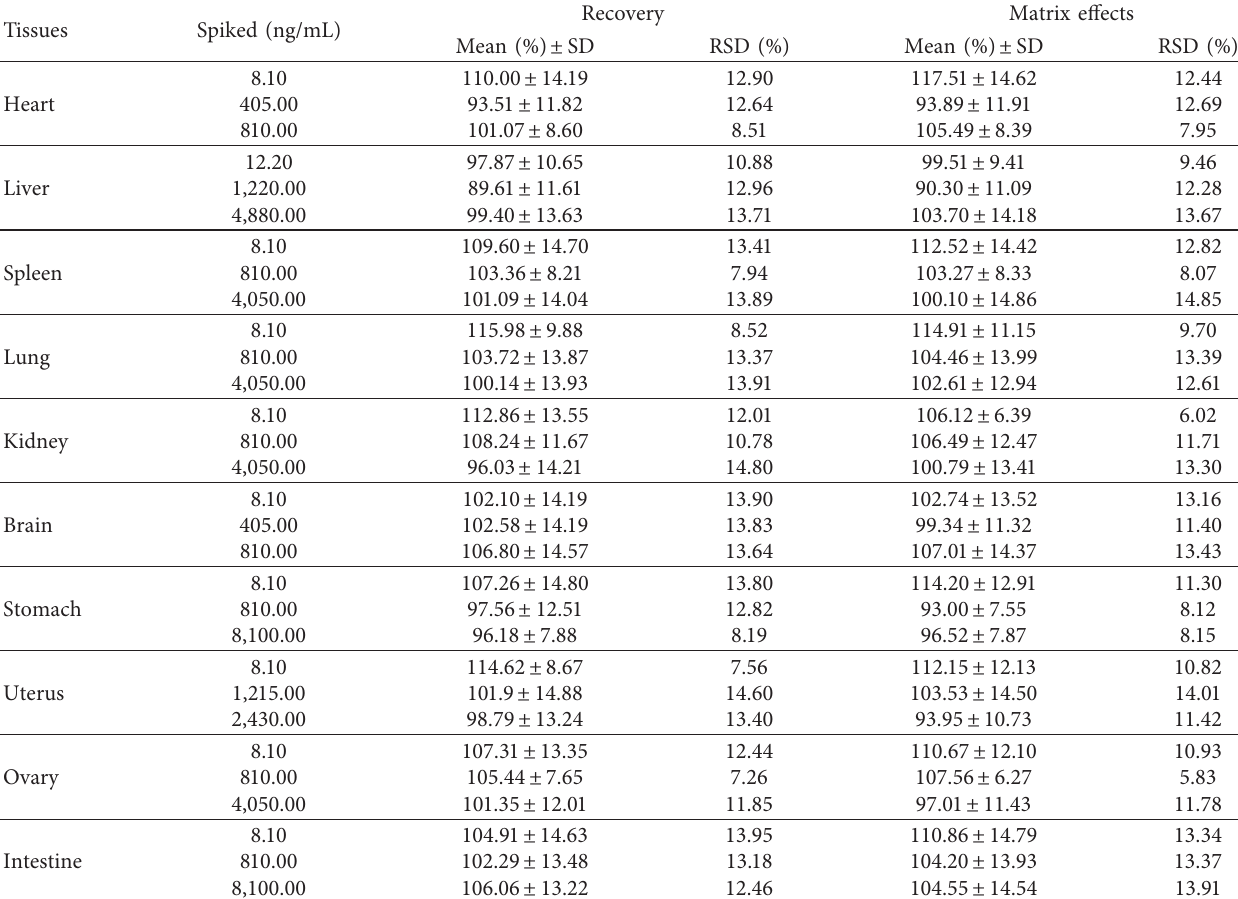
Table 13: Recovery and matrix effect study of naringin in rat tissues ( n � 6).